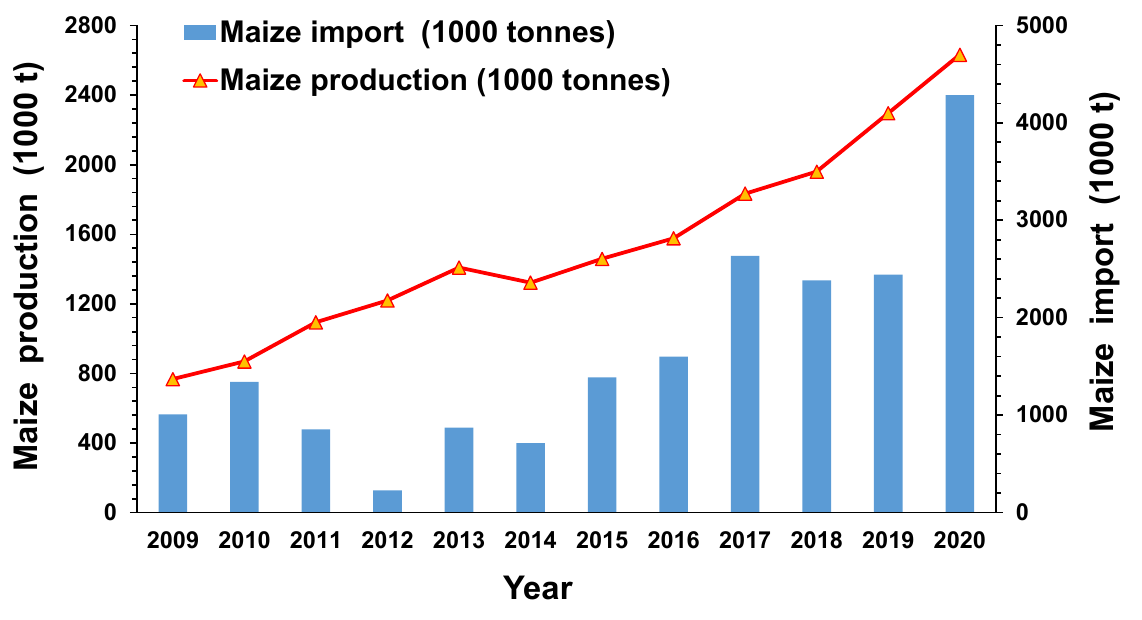
Figure 1. Rapid growth of maize production and imports in Bangladesh from 2009 to 2020 (Source: https://knoema.com/ (accessed on 11 January 2023)).